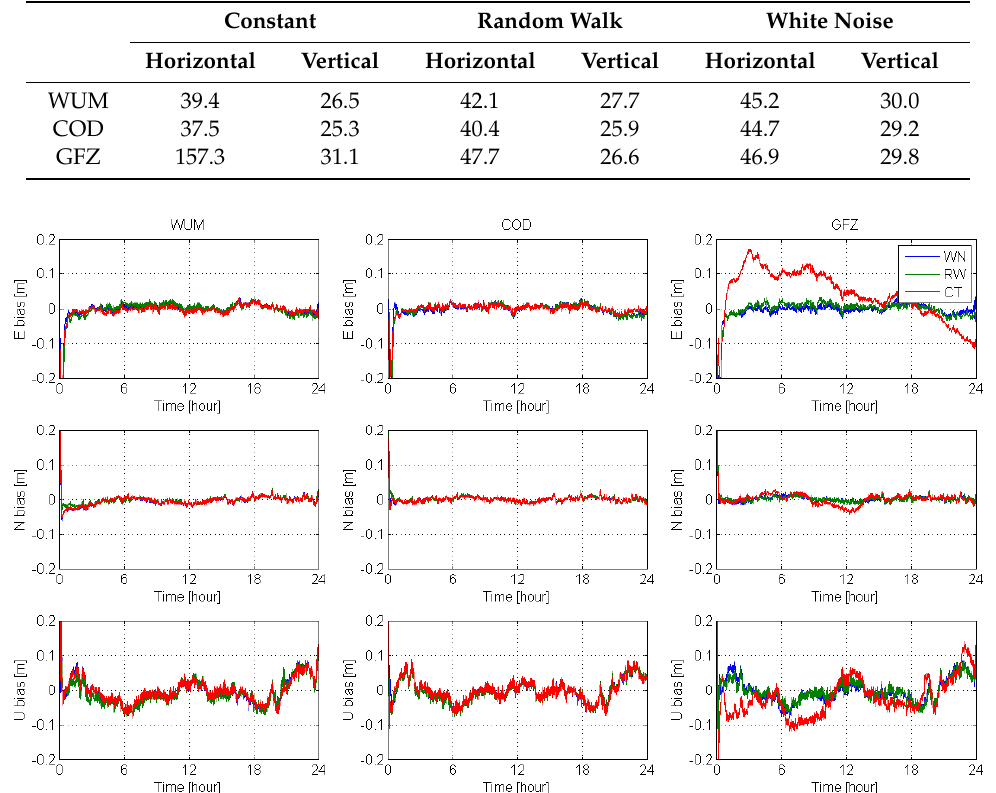
Figure 6. Positioning result of GPS / BDS PPP at station PNGM on DOY 252, 2018, using constant, random walk and white noise methods.